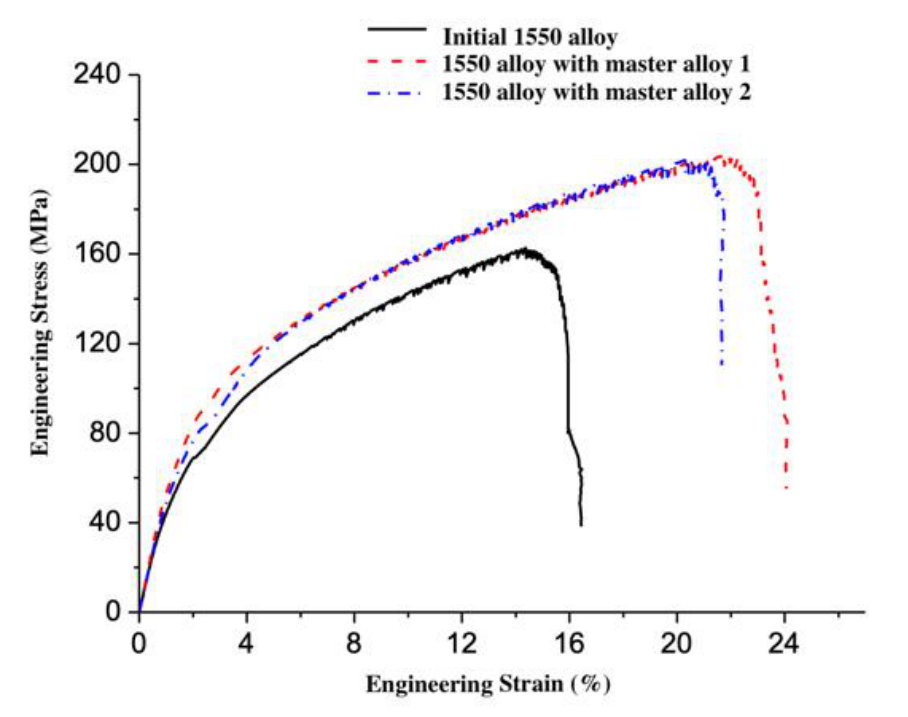
Figure 4. Typical stress–strain curves for the obtained alloys. The obtained values of the UTS and elongation at fracture ( ε , %) of the studied alloys are shown in Table 2. Table 2. Mechanical characteristics of the initial 1550 alloy and reinforced with two types of Al-TiB 2 master alloys.